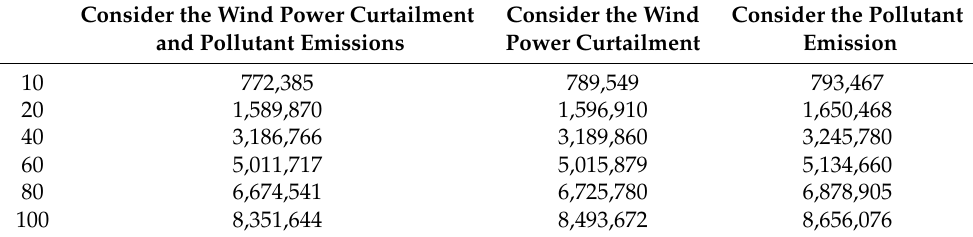
Table 4. Comparison total operation cost of three models.